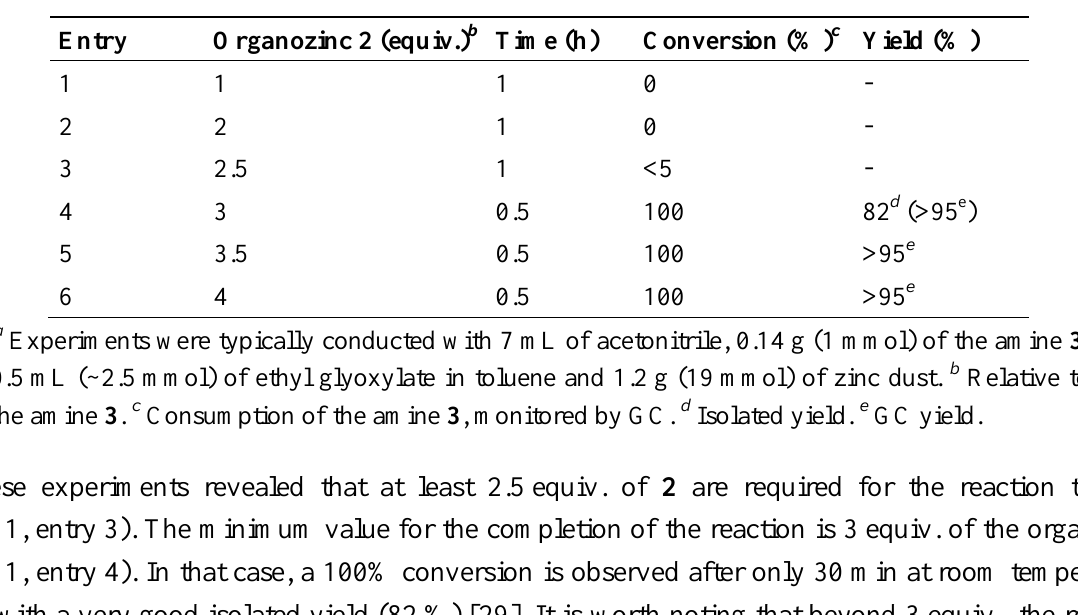
Table 1. Influence of organozinc amount. a